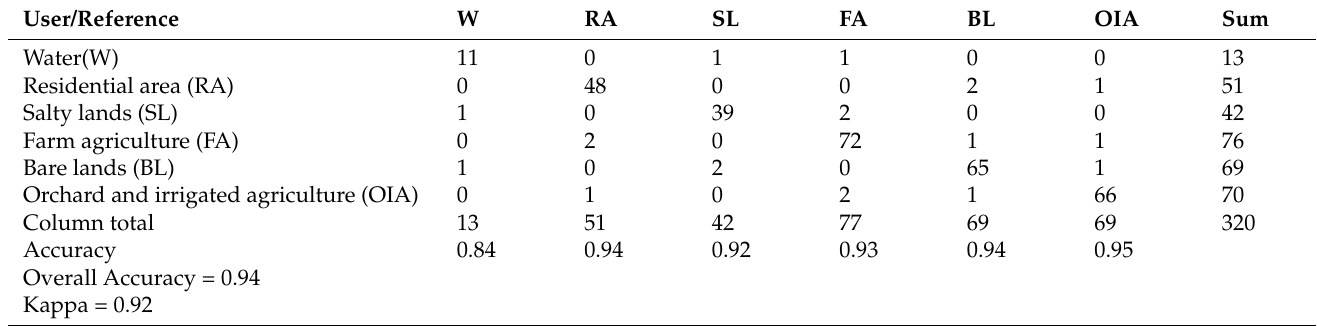
Table 6. Error matrix for accuracy assessment of LULC classification using OBIA (Naboureh et al.